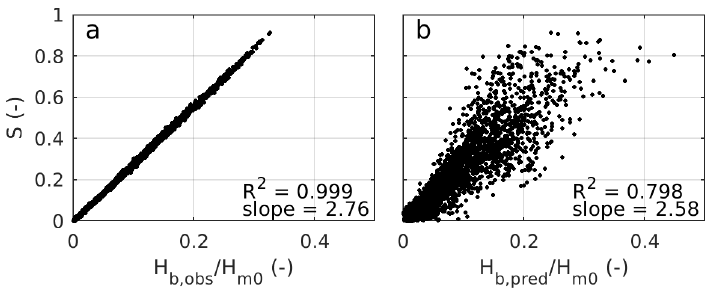
Figure 6. Dimensionless wave shape as a function of the dimensionless observed bound wave height ( a ) and the dimensionless predicted bound wave height ( b